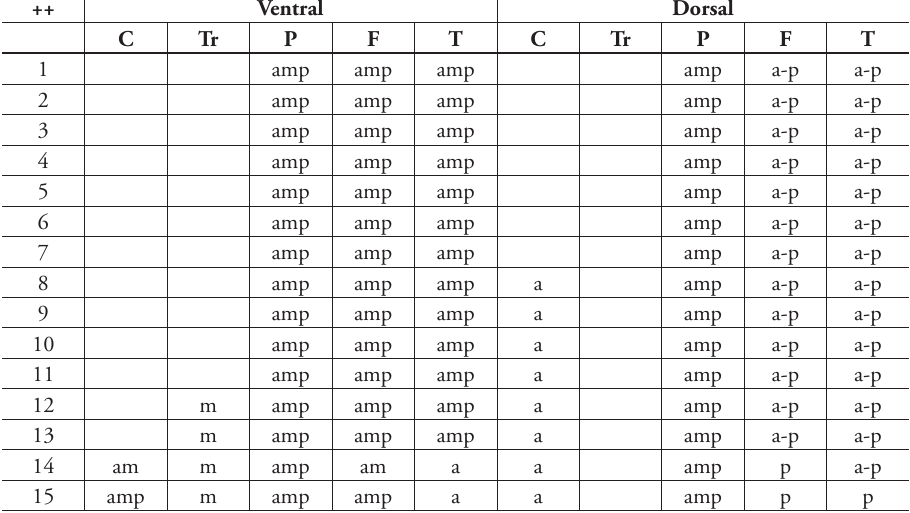
Table 1. Eupolybothrus liburnicus sp. n. plectrotaxy. C – Coxa, Tr – trochanter, P – prefemur, F – femur, T – tibia, a, m, p spines in respectively, anterior, medial and posterior